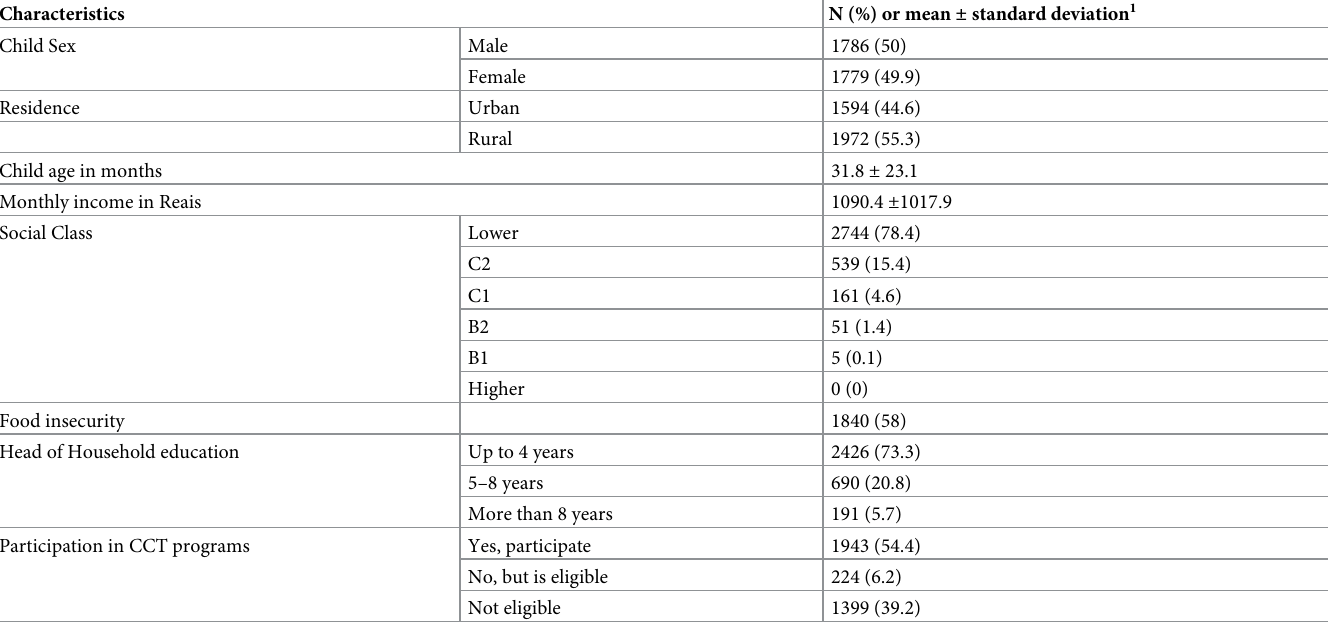
Table 1. Characteristics of households and participants who completed the Ages and Stages Questionnaire.